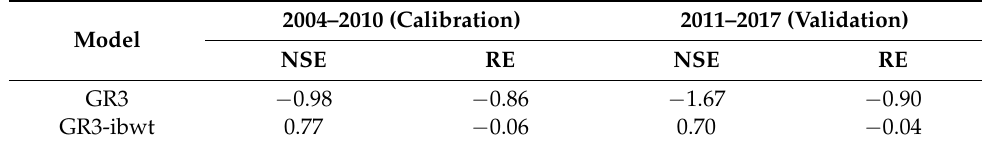
Table 4. The statistical analysis of the measured and simulated discharge in long time